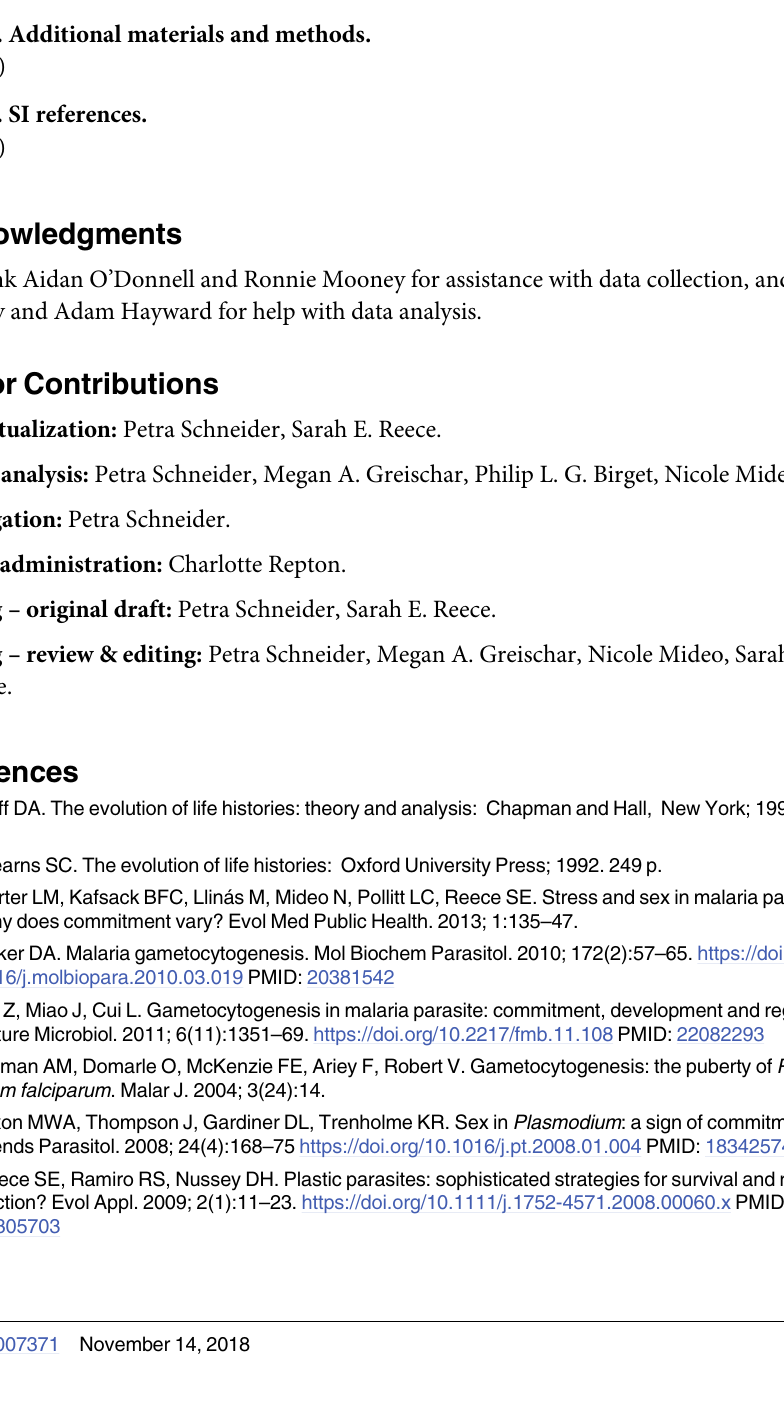
S2 Table. Statistical model selection to identify putative cues for conversion rate (CR) deci- sions. S3 Table. Parameter values used in the mathematical within-host model of state-depen- dent conversion rates. S4 Table. Comparison of infection parameters for the main experiment following P . cha- baudi genotype ER treated on day 11 PI and the day 11 PI for the additional data analysed for CWvir (treated on day 5